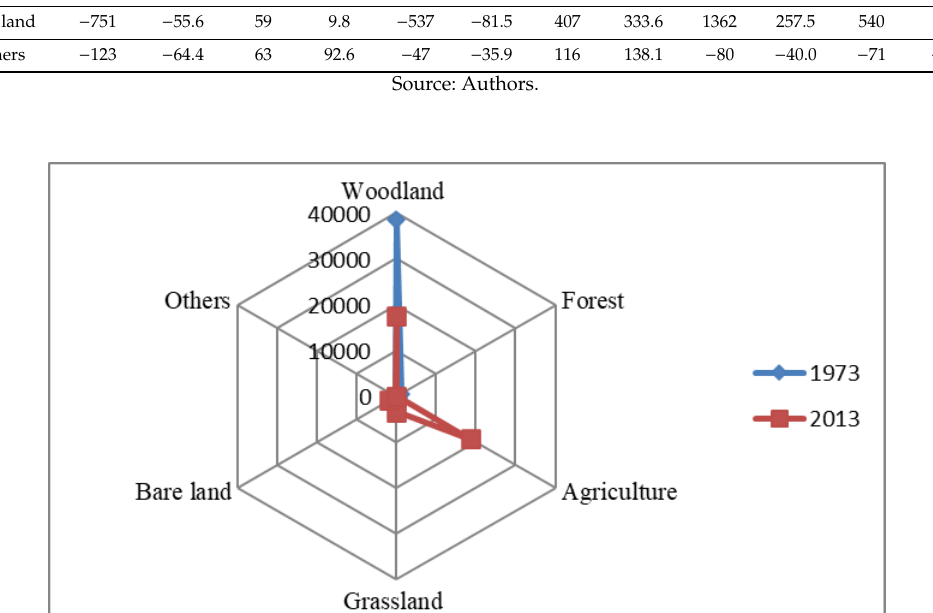
Figure 3. Radar chart displaying shifts in the pattern of land cover change in hectares between 1973 and 2013.